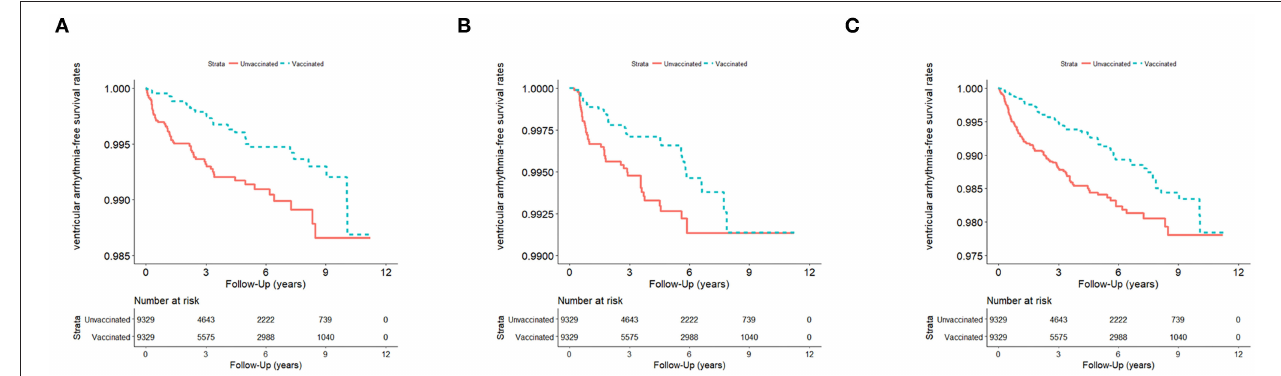
FIGURE 2 | (A) VA events in influenza season ( n = 18,658; January 1, 2001–December 31, 2012) in Taiwan, stratified by vaccinated and unvaccinated groups (log rank test, χ 2 = 10.686; df = 1; p = 0.001). (B) VA events in non-influenza season ( n = 18,658) from January 1, 2001 to December 31, 2012, in Taiwan, stratified by vaccinated and unvaccinated groups (log rank test, χ 2 = 4.101; df = 1; p = 0.063). (C) VA events in all seasons ( n = 18,658) from January 1, 2001 to December 31, 2012, in Taiwan, stratified by vaccinated and unvaccinated groups (log rank test, χ 2 = 14.272; df = 1; p < 0.001). VA, ventricular